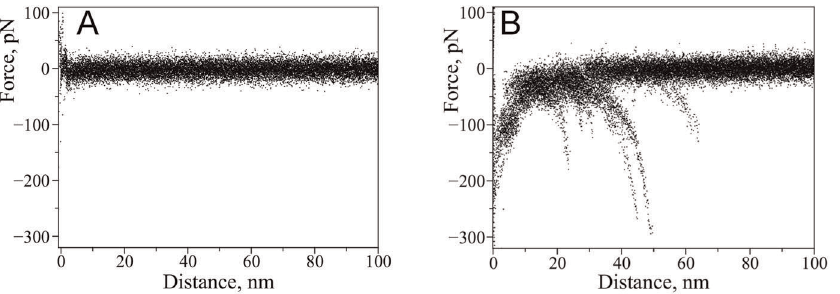
Figure 2. Effect of spermidine on the appearance of force-distance curves with wild-type alpha-synuclein. Superposition of representative force-distance curves measured upon probing of interactions between wild type alpha-synuclein molecules: A) in the absence of spermidine (22 curves), B) with addition of 5 mM spermidine (26 curves).